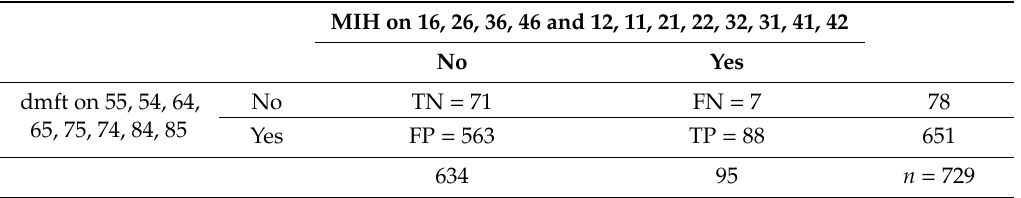
Table 2. Relationship between deciduous teeth (decayed, missing, and filled teeth; dmft) and MIH.